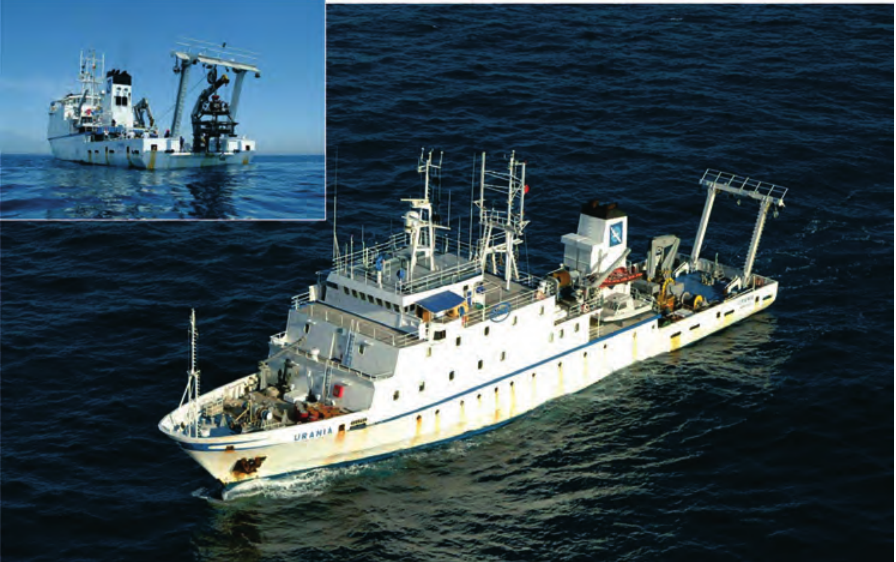
Fig. 1. R/V Urania, a medium-size vessel (overall length: 61 m; gross tonnage: 1100 t) owned by CNR and managed by SoProMar. The top-left corner shows the ship during the launch of a GEOSTAR-class